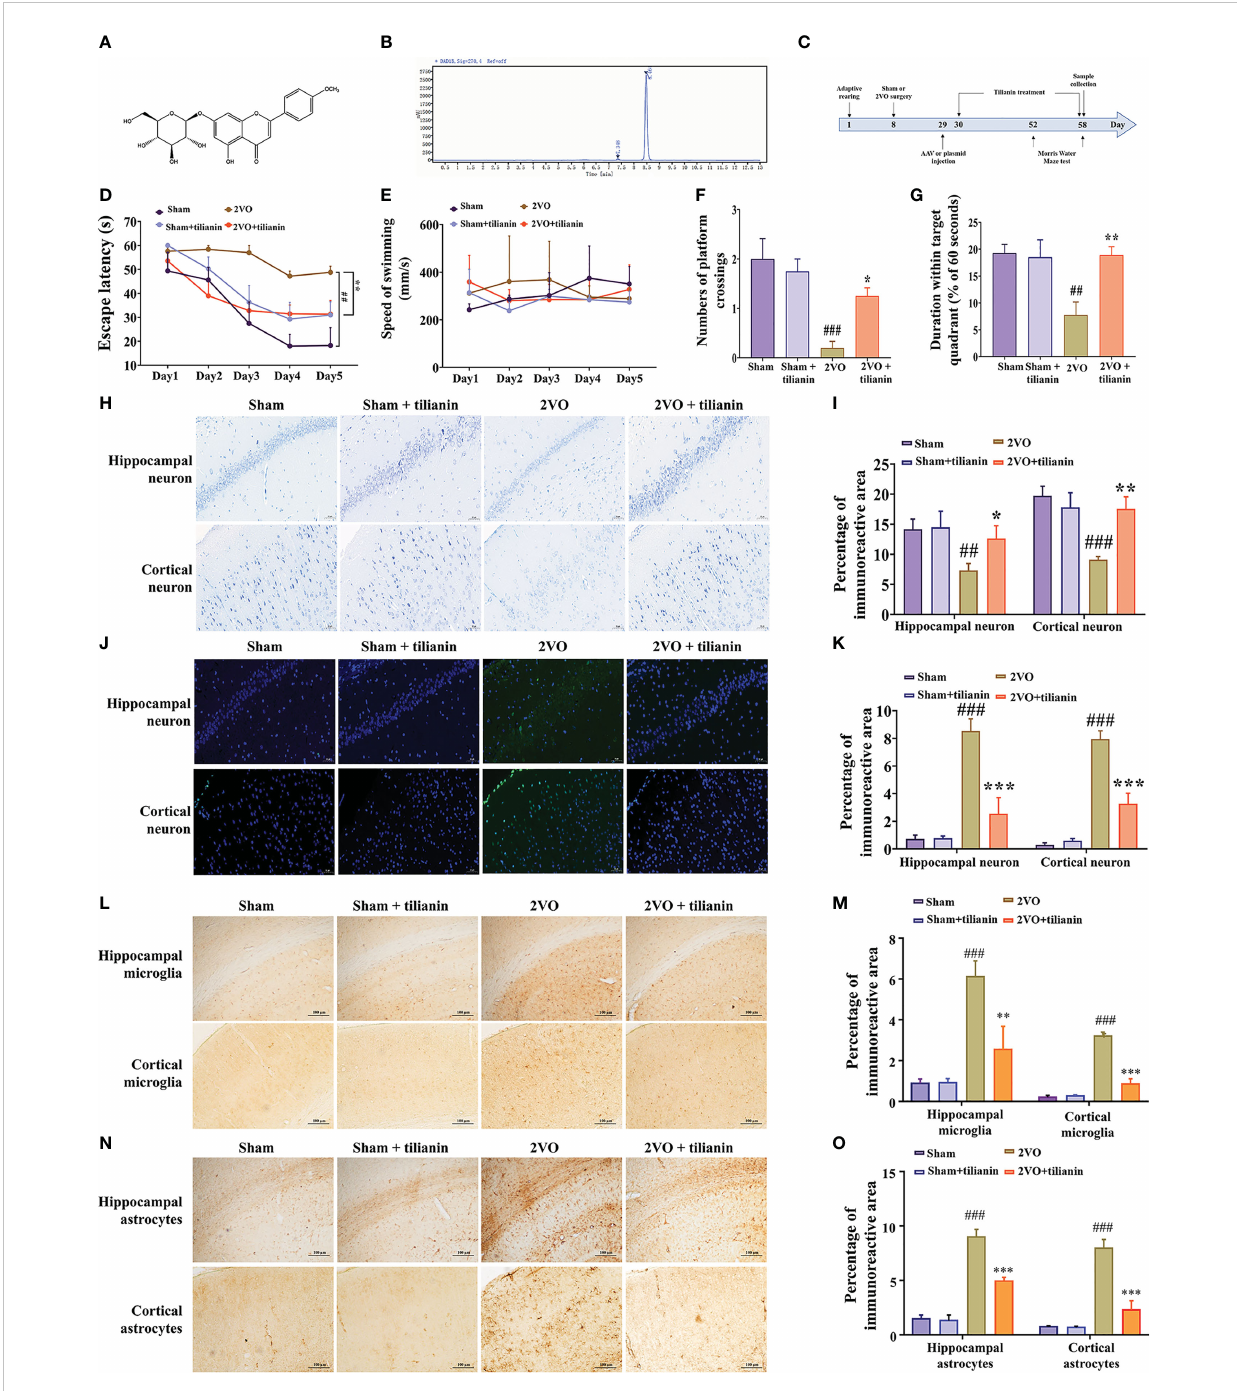
FIGURE 1 Effects of tilianin on cognitive decline, neurodegeneration, and neuroin fl ammation in 2VO rats. (A) Chemical structure of tilianin. (B) HPLC chromatogram of tilianin. The purity of tilianin is 99.02%. The retention time of tilianin peak is 8.464 min. (C) Overview of the experimental design, including the surgical procedures, tilianin treatment, and gene modi fi cation administration. (D) Escape latency of 2VO rats in the MWM navigation test ( n = 8). (E) Swimming speed of rats in the navigation test ( n = 8). (F) Number of platform crossings by 2VO rats ( n = 8). (G) Duration within the target quadrant for 2VO rats ( n = 8). (H) Representative images of Nissl-stained cortical and hippocampal neurons ( n = 3). Scale bar = 50 m m. (I) Quantitative analysis of immunoreactivity of Nissl staining in the cerebral cortex and hippocampus of 2VO rats ( n = 3). (J) Representative images of TUNEL-stained cortical and hippocampal neurons ( n = 3). Scale bar = 50 m m. (K) Quantitative analysis of immunoreactivity of TUNEL staining in the cerebral cortex and hippocampus of 2VO rats ( n = 3). (L) Representative images of IBA1-stained cortical and hippocampal microglia ( n = 3). Scale bar = 100 m m. (M) Quantitative analysis of immunoreactivity of IBA1 staining in the cerebral cortex and hippocampus of 2VO rats ( n = 3). (N) Representative images of GFAP-stained cortical and hippocampal astrocytes ( n = 3). Scale bar = 100 m m. (O) Quantitative analysis of immunoreactivity of GFAP staining in the cerebral cortex and hippocampus of 2VO rats ( n = 3). The results indicate the mean ± SD. ## P <0.01, ### P <0.001 vs. sham, * P <0.05, ** P <0.01, *** P <0.001 vs.